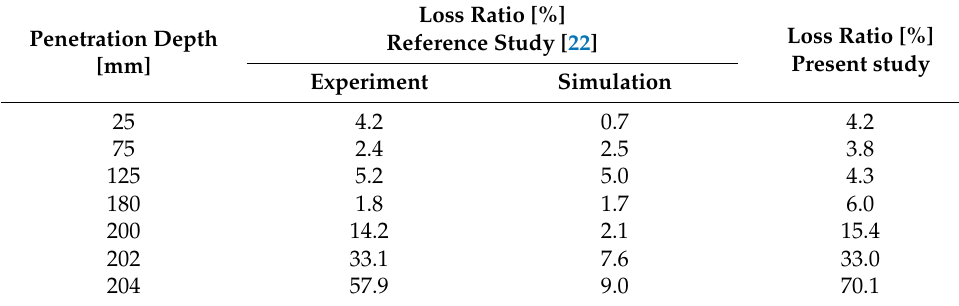
Figure 9. Comparison of wear shape: ( a ) reference study [22]; ( b ) present study. Table 3. Loss ratio comparisons between reference and present study.